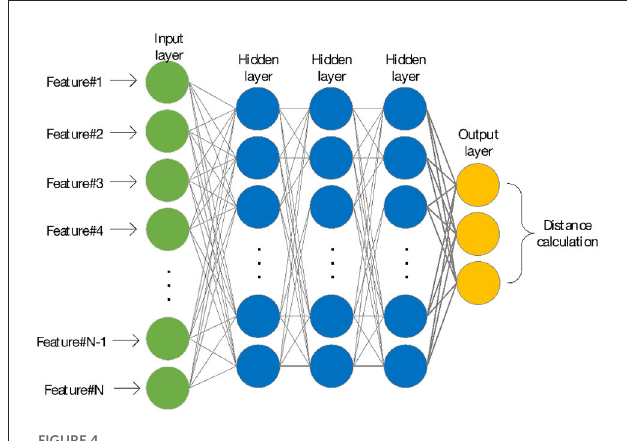
FIGURE4 The structure of the environment agent consists of three hidden